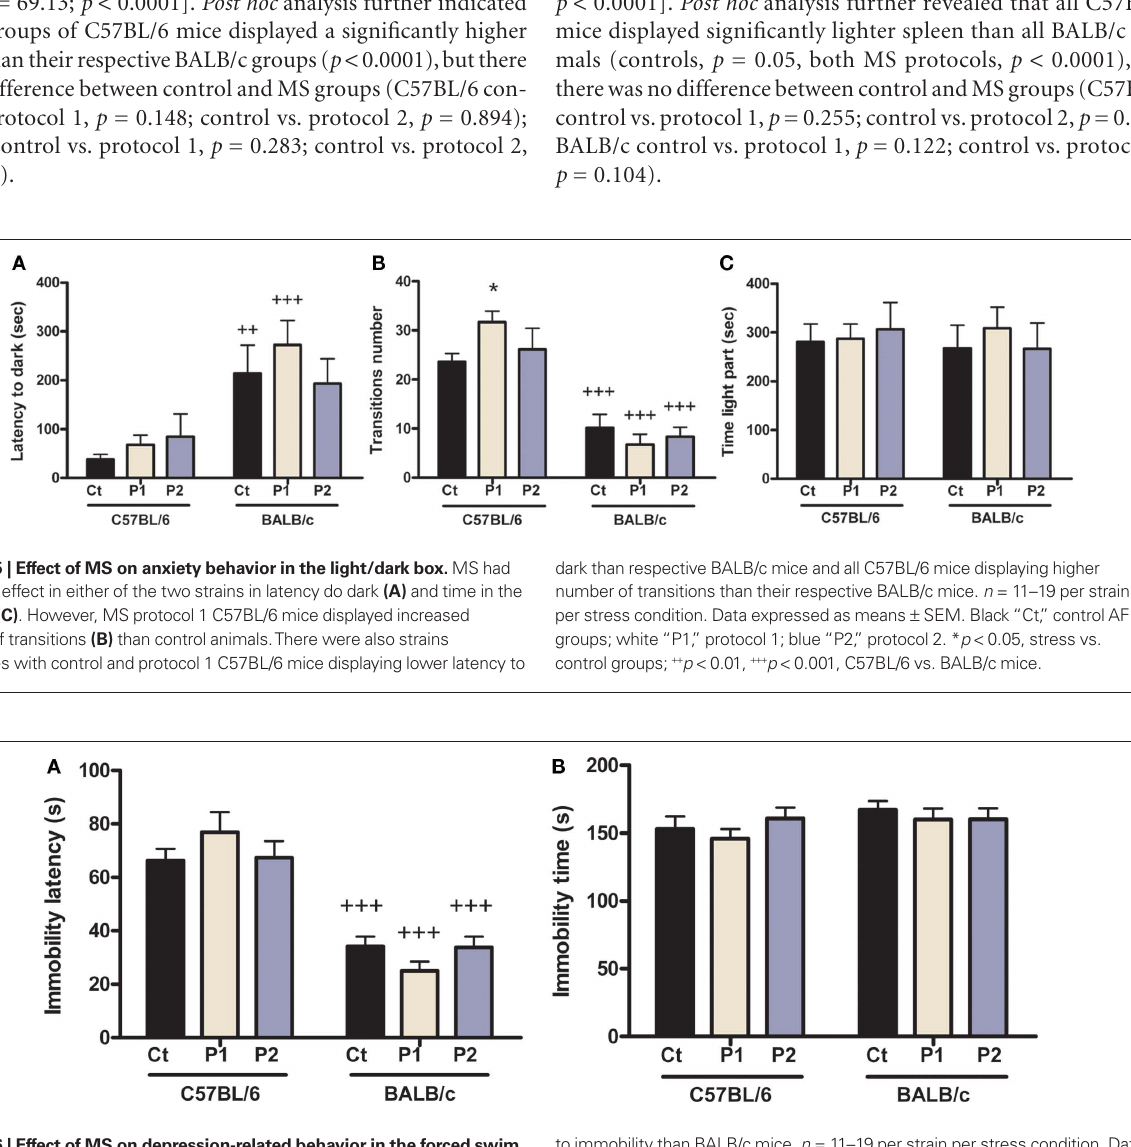
Figure 6 | effect of MS on depression-related behavior in the forced swim test. MS had no overall effect in either strain in latency to immobility (A) or time of immobility (B) . However, C57BL/6 mice of all groups displayed longer latency